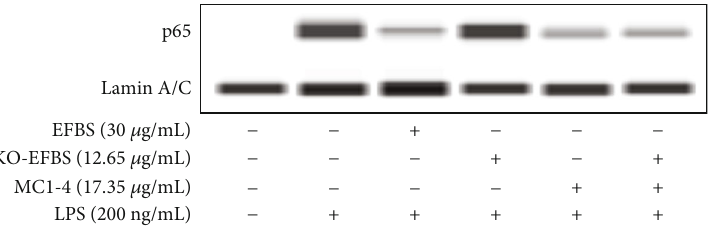
Figure 11: Western blot of p65 nuclear